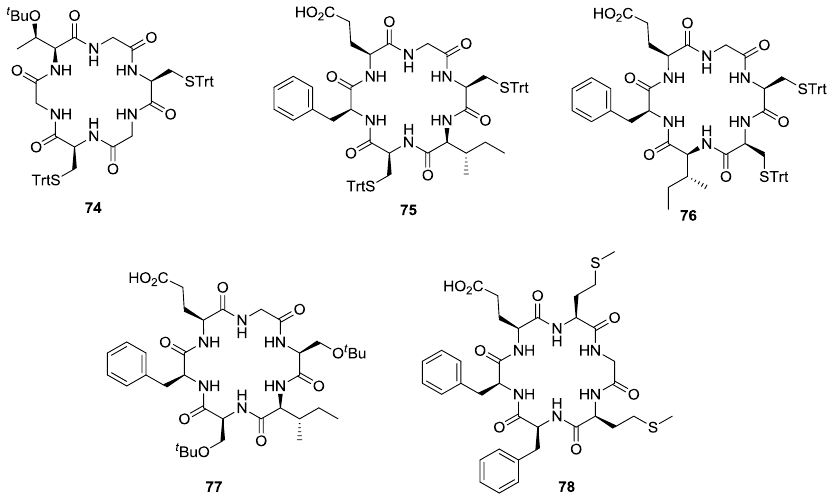
Figure 13. Structures of cyclohexapeptides 74 – 78 .